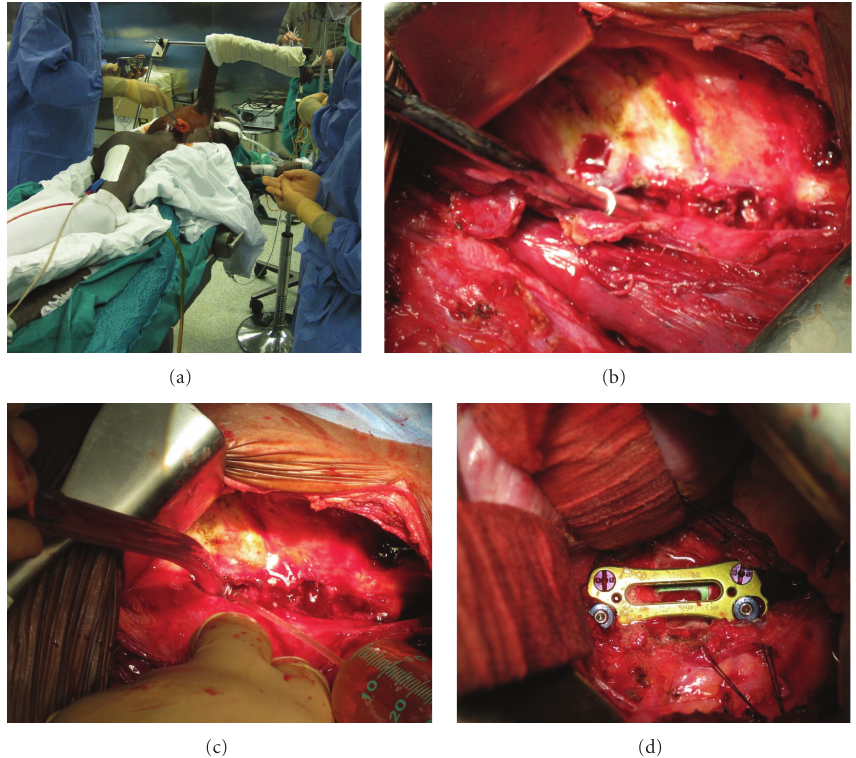
Figure 4: (a) Picture of the position of a patient in the operating room for the lateral thoracotomy approach, with the ipsilateral arm raised. (b) Intraoperative picture showing bone erosion by the infection. (c) During the surgical procedure the site is repeatedly washed with 0.9% physiological solution so as to clear as much as possible the surgical field. (d) Final intraoperative picture. It shows the placement of the mesh and the